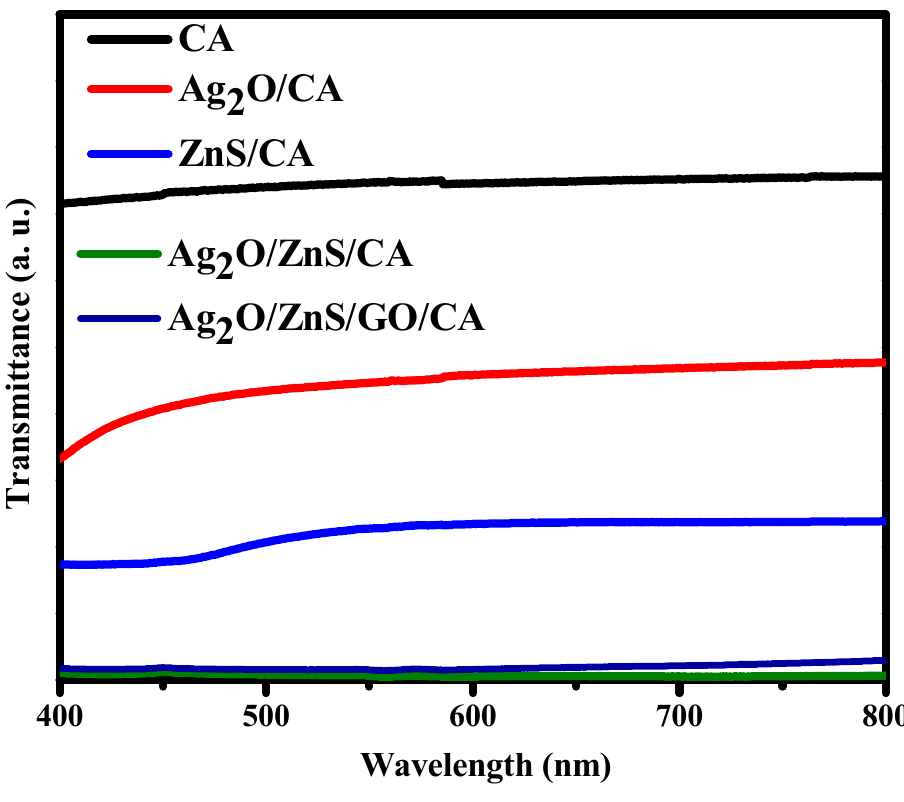
Figure 7. UV-Vis transmittance measurement for all composites.